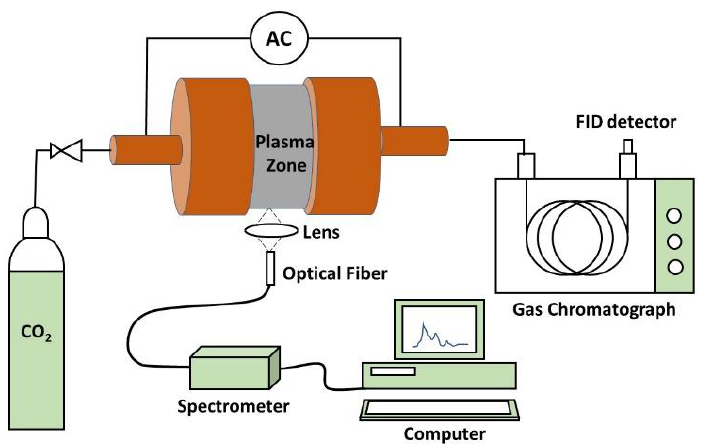
Figure 1. Experimental arrangement.